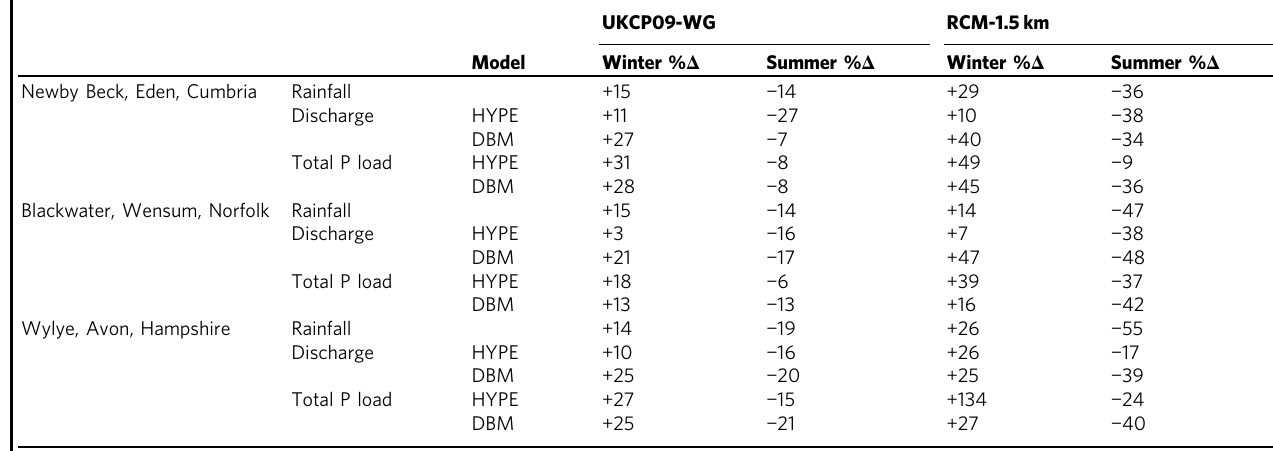
Table 2 Future predicted percentage changes in hydrology and total phosphorus loads for three catchments in the